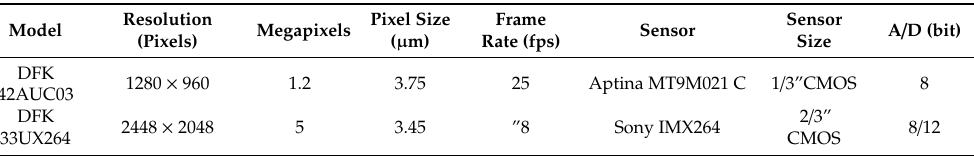
Table 2. Main technical data of lenses used in the prototype (from the Imaging Source Europe GmbH company and FUJIFILM Corporation).